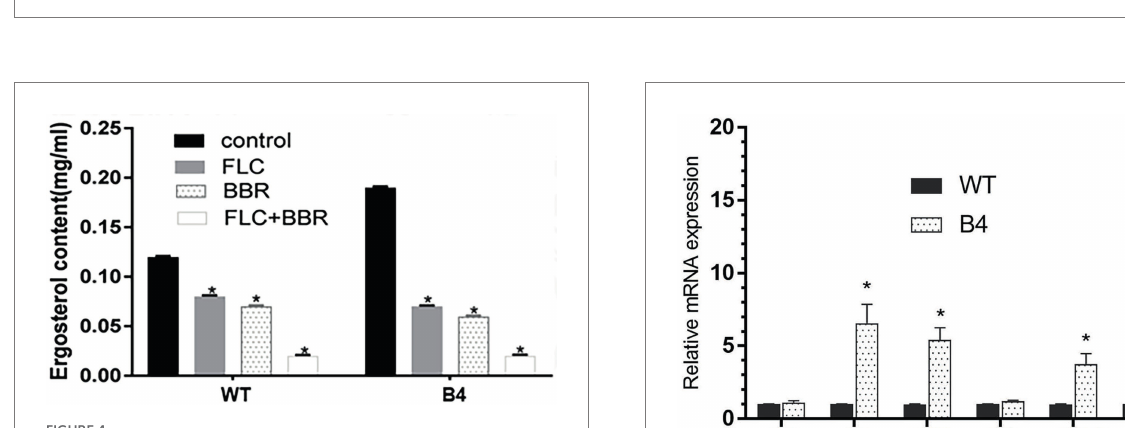
FIGURE 3 Effects of BBR and/or FLC on ROS production in (WT,B4) . For (WT) : Cells were treated with BBR (32 μ g/ml) and/or FLC (2 μ g/ml) 24 h and incubated with DHR-123 for 30 min. For (B4) : Cells were treated with BBR (32 μ g/ml) and/or FLC (256 μ g/ml) 24 h and incubated with DHR- 123 for 30 min.